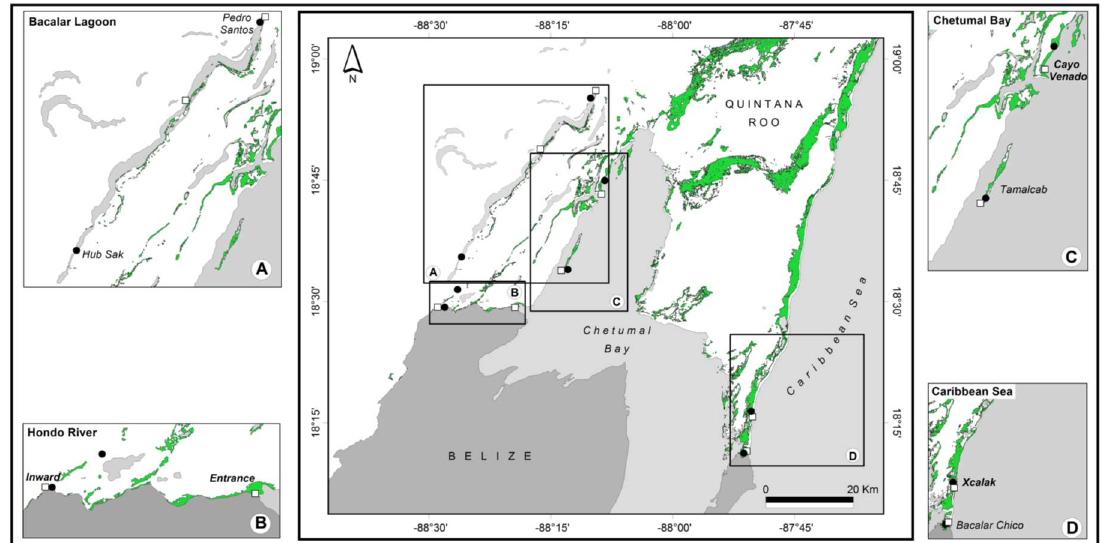
Figure 1. Hydrological systems and localities in the TCC system in Southern Quintana Roo, Mexico, where Rhizophora mangle tree samples were collected. Hydrological systems: Bacalar Lagoon (A), Hondo River (B), Chetumal Bay (C), and Caribbean Coast (D). Black circle (dwarf mangrove trees), white square (fringe mangrove trees), light grey areas (water bodies), green areas (mangrove forest cover, source: “Comisión Nacional para el Conocimiento y Uso de la Biodiversidad” CONABIO 2016).